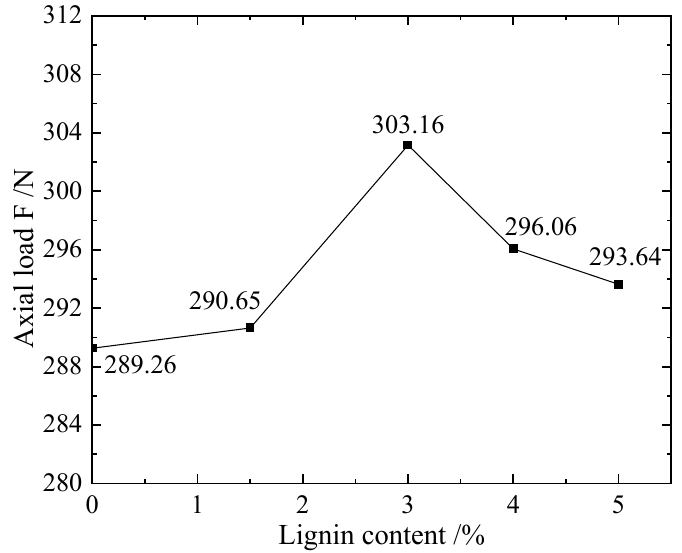
Figure 10. E-L scheme sample: the ratio of lignin added and the axial load F diagram.